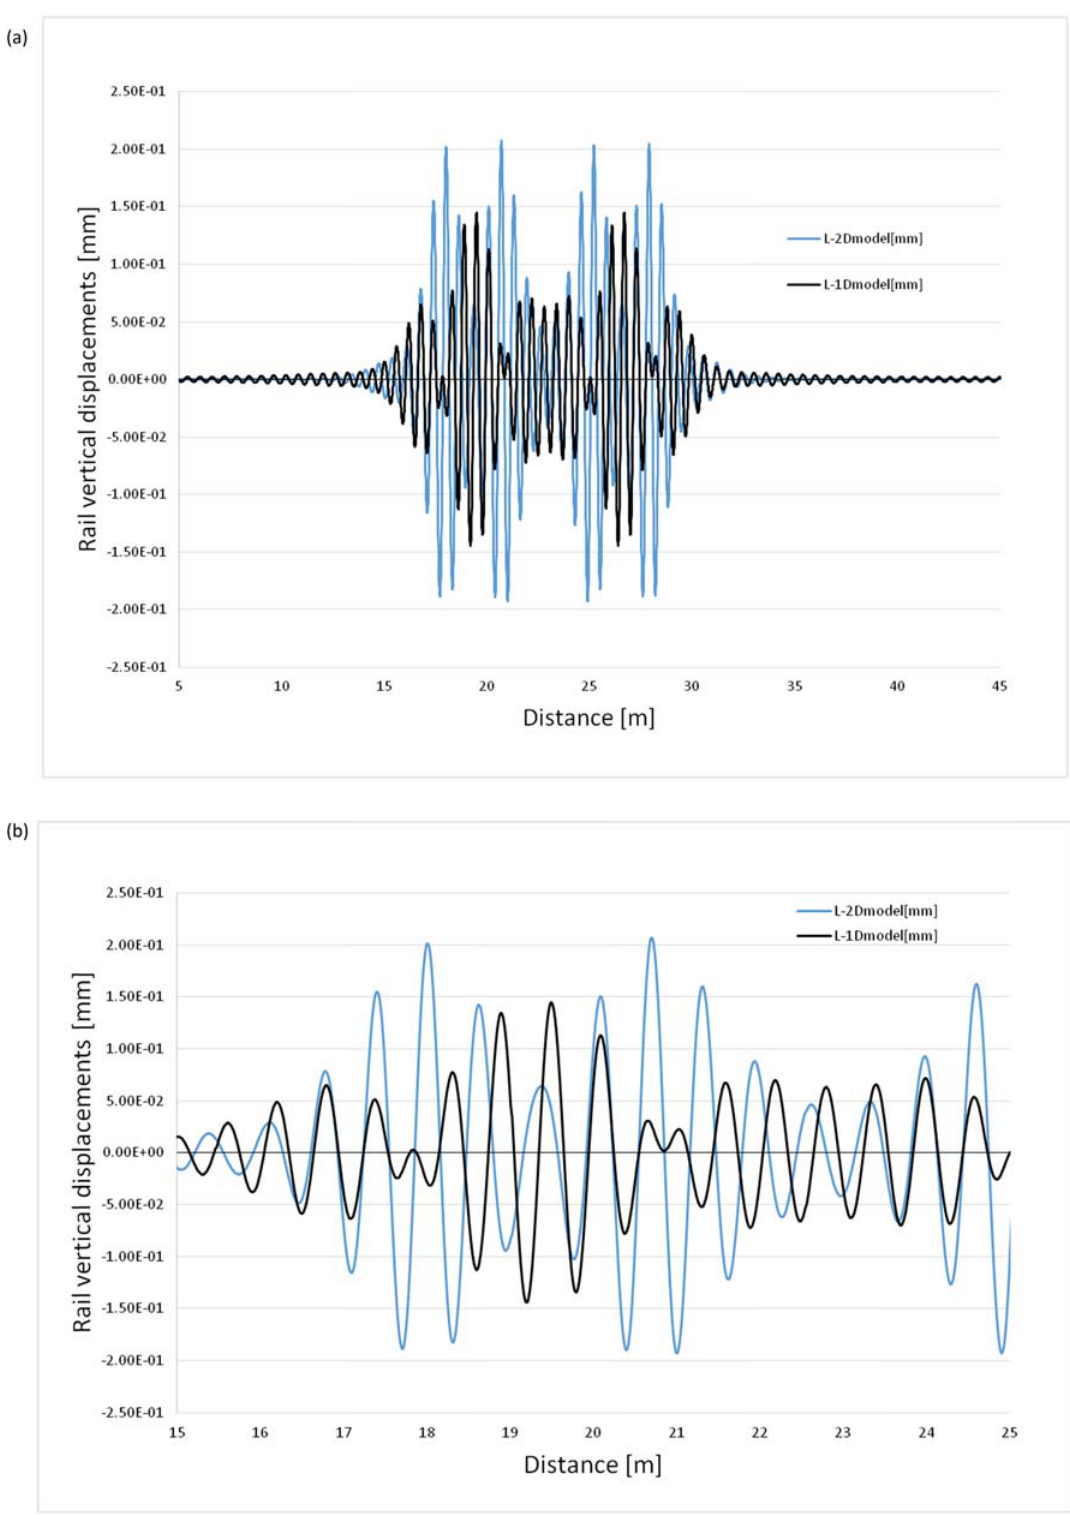
Figure 3: ( a ) The whole rail displacements for a two - layer ( L - 2D model ) and a one - layer ( L - 1D model ) models ( Pendolino train, v = 300 km/h, k = 91.1 MPa, imperfection s = 10 μ m, and L r